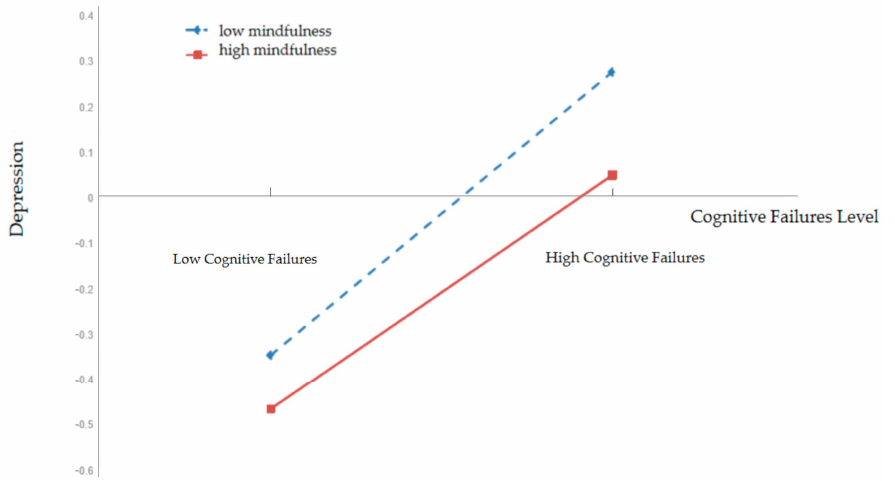
Figure 2. Mindfulness as a moderator of cognitive failures and depression ( n =